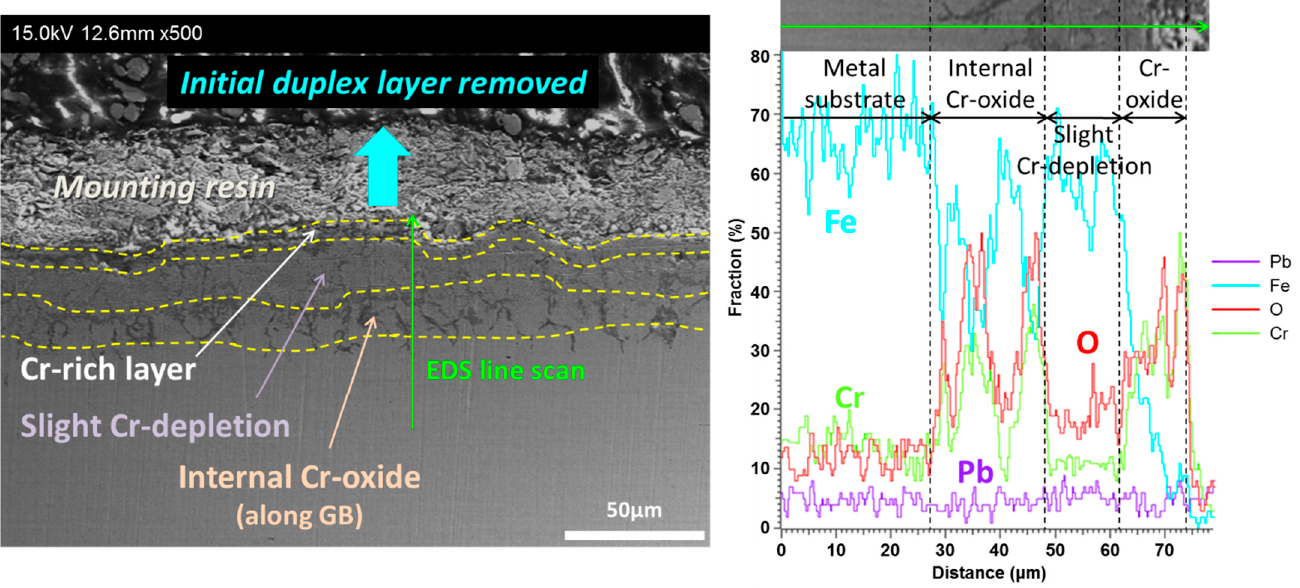
Figure 7. EDS analysis of Cr-rich layer, Cr-depleted zone, and internal Cr oxide along the grain boundaries of T91 after 2000 h at 600 °C.